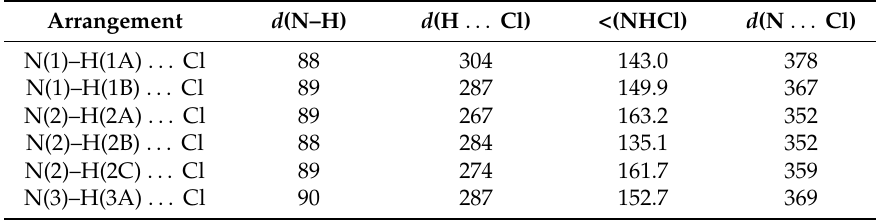
Figure 2. Sections of the crystal structure of [Zn 2 (NH 3 ) 2 (NH 2 ) 3 ]Cl: ( a ) every chloride ion employs twelve H-bonds and ( b ) connects two adjacent layers 2 ∞ dimension ( yellow spheres: Cl, green spheres: N, red spheres: H, and blue spheres surrounded by grey tetrahedra: Zn). Table 4. Donor–acceptor distances (pm) and angles (deg.) in [Zn 2 (NH 3 ) 2 (NH 2 ) 3 ]Cl.